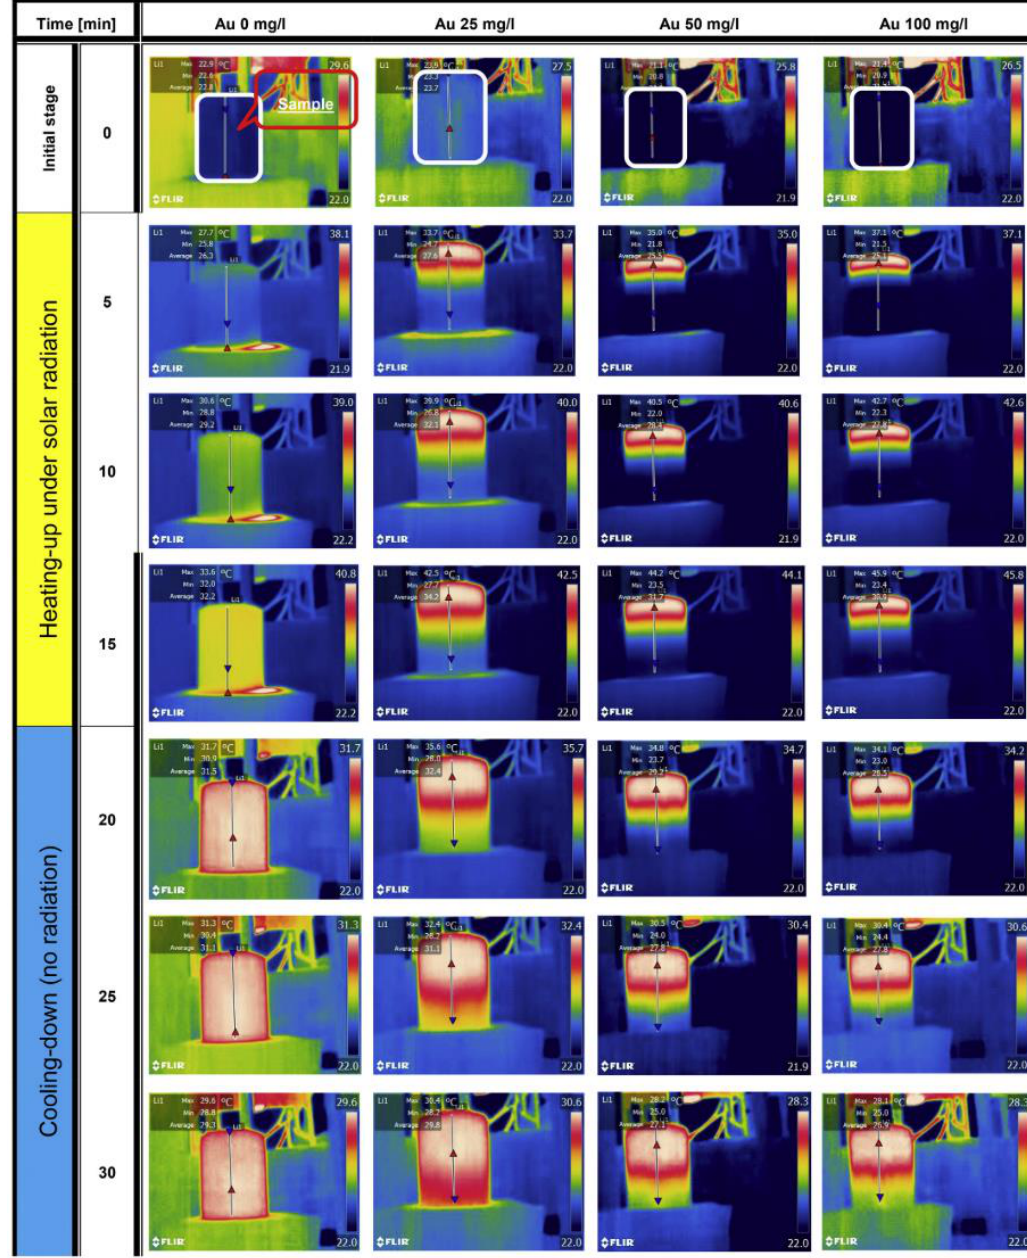
Figure 31. Heating (under radiation) and cooling (no radiation) process of gold nanofluid with different nanofluid concentrations [100]; 2018, Elsevier.